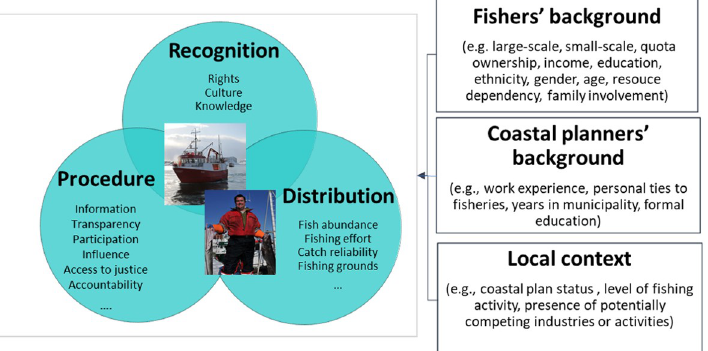
Fig 4. Illustrating associations that can be explored statistically using a social survey approach (e.g., the associations between perceptions of justice, coastal planners’ and fishers’ background and local contextual variables). Photos by the Norwegian Society for Sea Rescue, Flickr under a CC BY-NC-SA 2.0